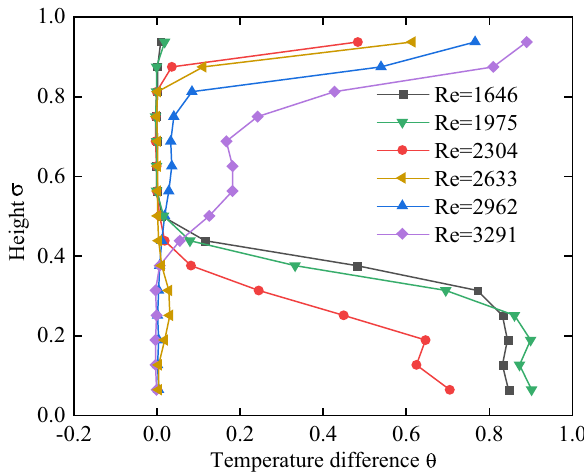
Fig. 9 The temperature change of L1 when Fo is